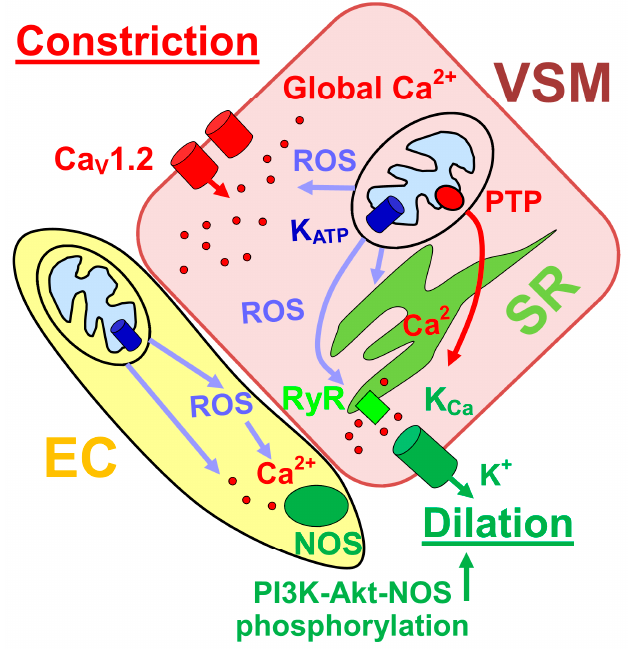
Figure 2. Pathways of mitochondria-mediated control of cerebral artery diameter. A balance between constriction and dilation is achieved by a plethora of mechanisms. Vasoconstrictive mechanisms include vascular myocyte mitochondrial amplification of hydrogen peroxide signaling that result in activation of Ca 2+ entry into the myocyte and upregulation of Ca V 1.2 channel transcription. Increase in vascular smooth muscle (VSM) global Ca 2+ is accompanied by an opening of the permeability transition pore (PTP) and a decreased Ca 2+ spark and K Ca [75]. Dilatory mechanisms include pathways within VSM as well as endothelial cells (EC). Mitochondrial depolarization via K ATP channel activation within VSM results in ROS-dependent, and independent activation of Ca 2+ sparks release from sarcoplasmic reticulum (SR). Ca 2+ sparks activate voltage- and Ca 2+ -gated potassium channels of large conductance (K Ca ). The latter generate outward potassium currents that negatively feedback on depolarization-driven Ca 2+ entry into the myocyte [78]. VSM-mediated vasodilation is further bolstered by ROS-dependent and independent mechanisms that trigger phosphoinositide 3-kinase (PI3K)–Akt–NOS phosphorylation within EC and thus increase production of vasodilator nitric oxide. Mitochondrial depolarization within EC is accompanied by an increase in EC intracellular Ca 2+ . Despite the involvement of mitochondria in vasoconstrictive mechanisms, a plethora of mitochondria-mediated vasodilatory responses has also been reported in the cerebral vasculature. It has been shown that mitochondria-derived ROS give rise to an increase in transient K Ca currents that are